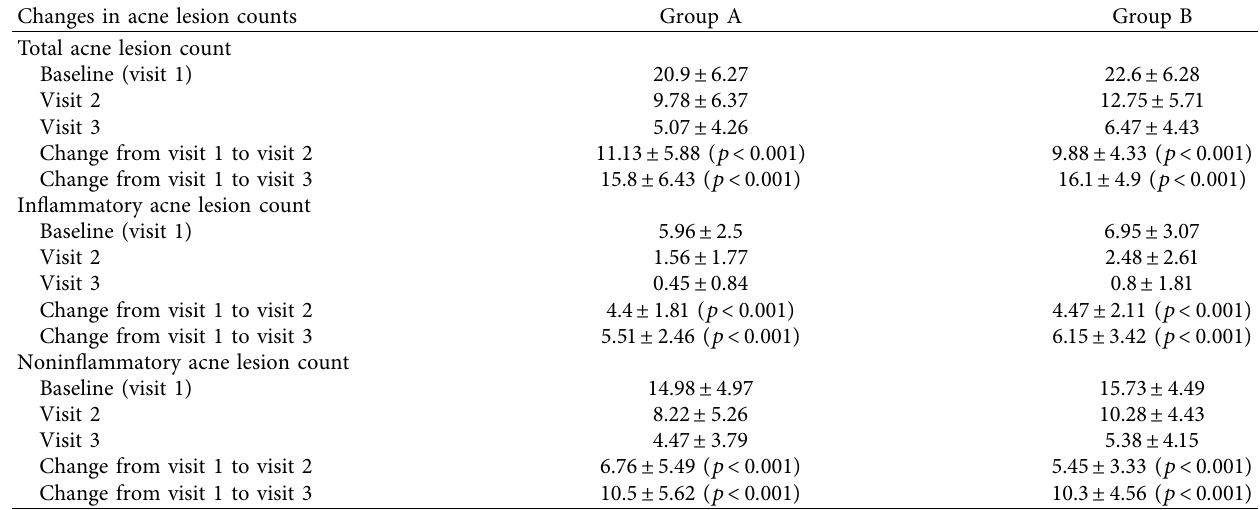
Table 2: Total acne lesion count during visits in both groups.